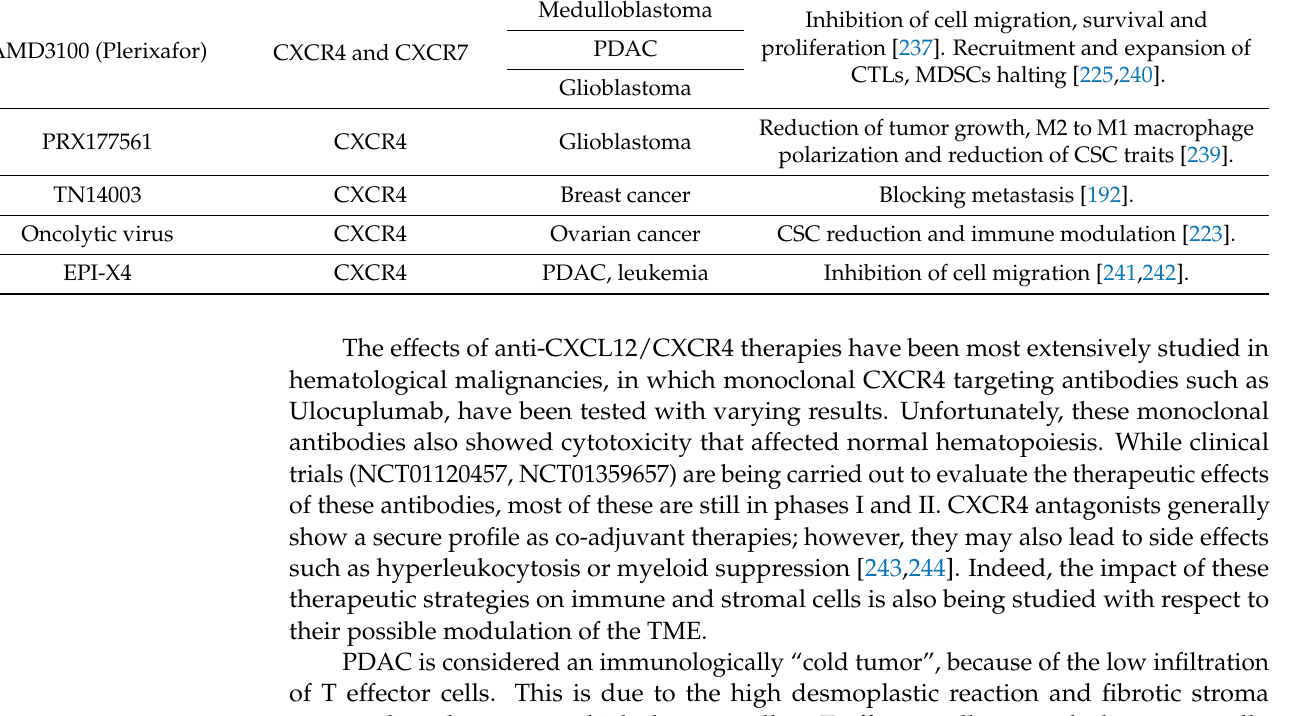
Table 2. Summary of the different drugs proposed to target the CXCL12/CXCR4/CXCR7 axes in cancer.